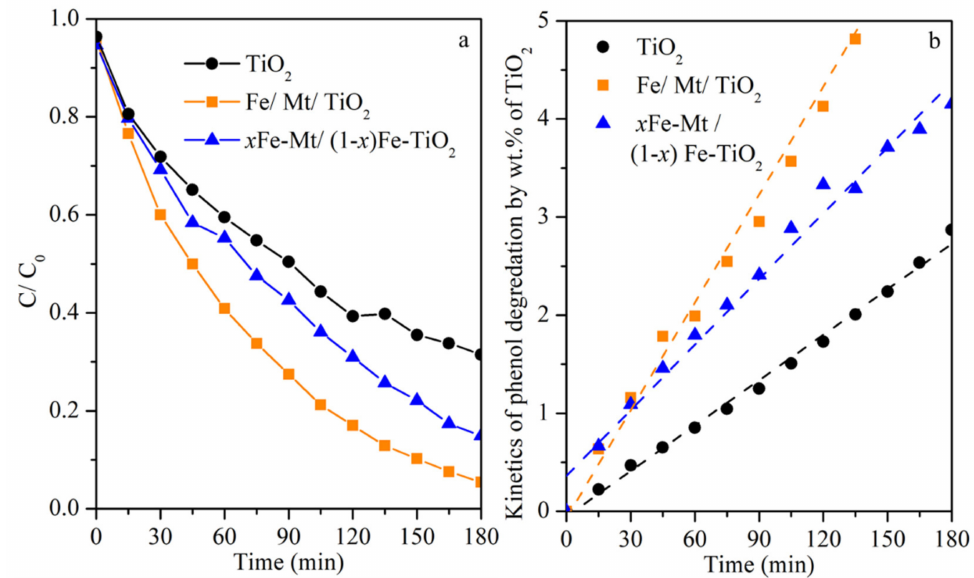
Figure 9. ( a ) Photocatalytic degradation and ( b ) kinetics of phenol by TiO 2 , Fe/Mt/TiO 2 and x Fe-Mt/(1 − x ) Fe-TiO 2 composites synthesized at 70 ◦ C.